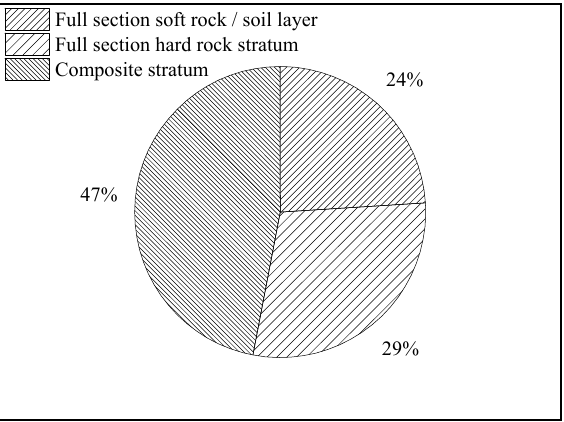
Figure 5. Proportion of various strata along the longitudinal direction of the tunnel. Table 2. Physicomechanical properties of encountered ground types